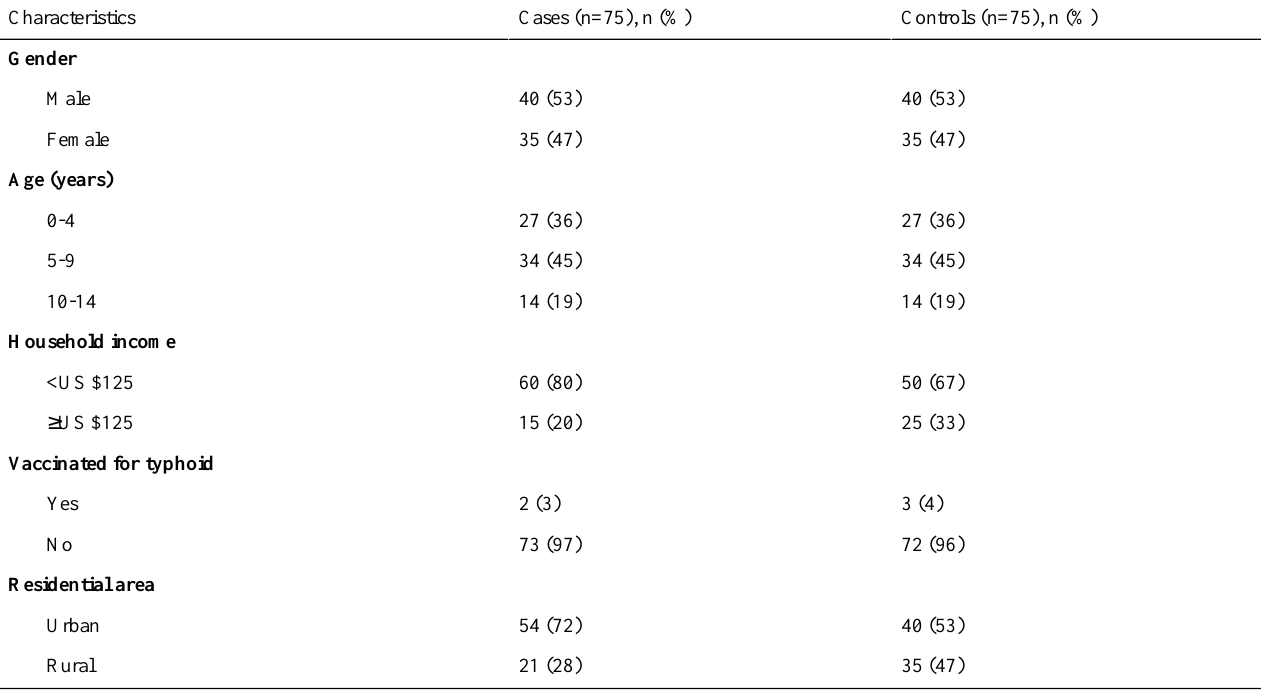
Table 1. The characteristics of 75 cases of extensively drug resistant typhoid fever and 75 age- and sex-matched controls in Karachi, Pakistan, in 2018.